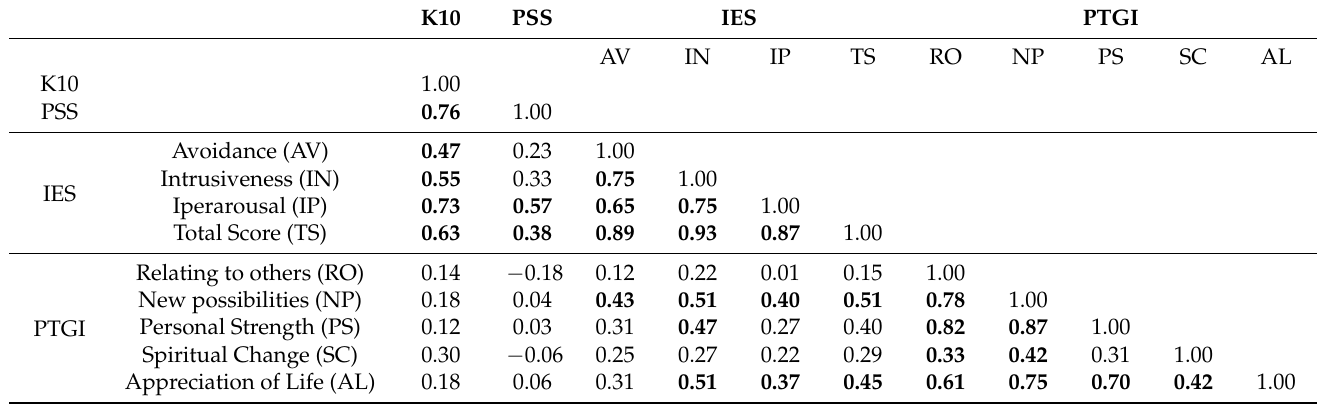
Table 2. Associations between K10, PSS, IES, and PTGI scores in all